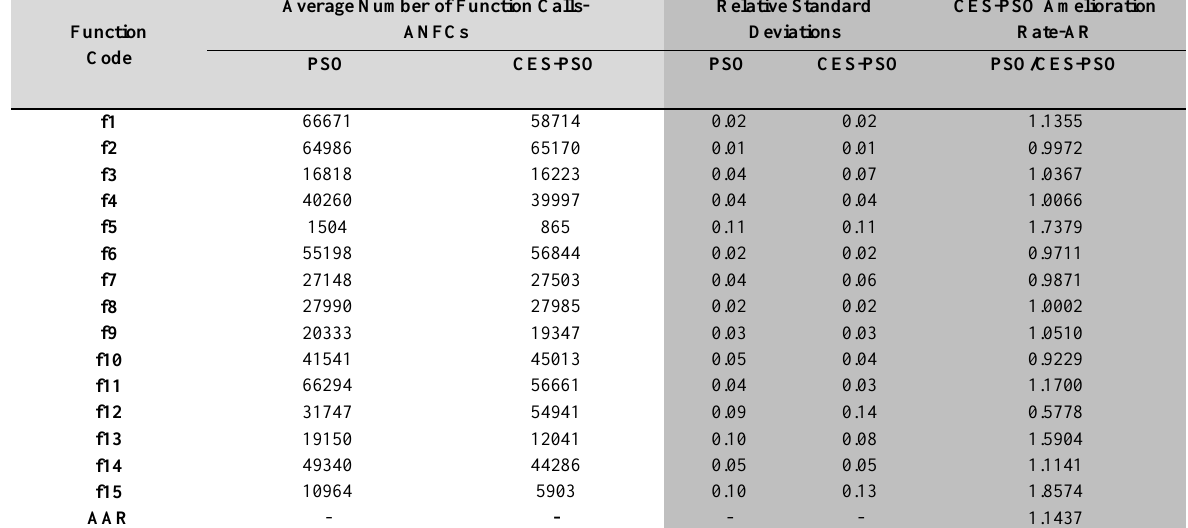
Table 4. Comparison of CES-PSO with classical PSO algorithm on CEC’17 test